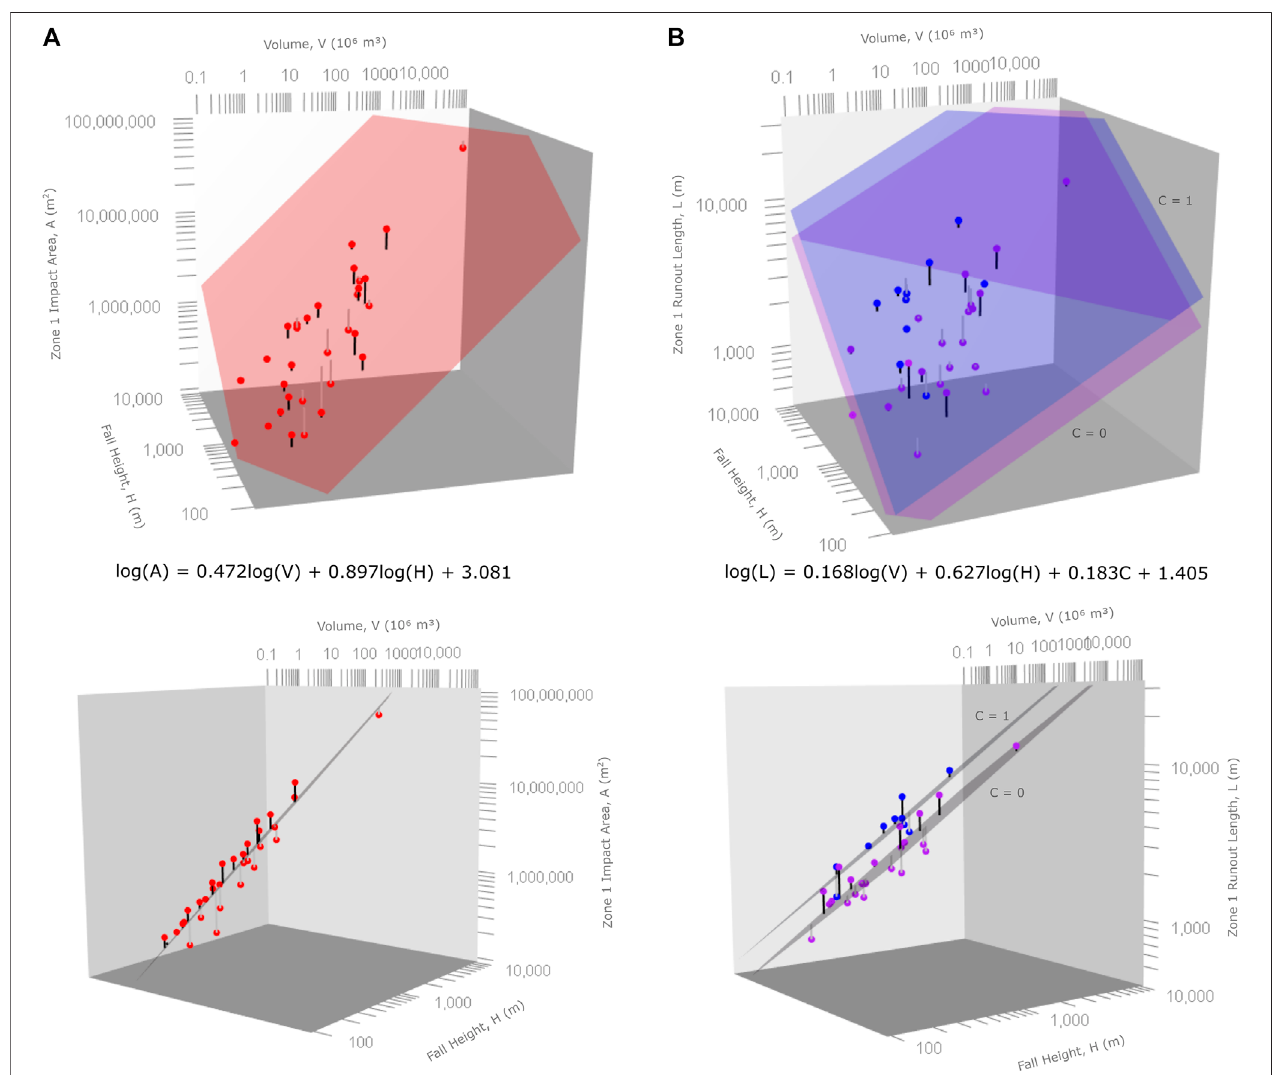
FIGURE 8 | Regression plots for (A) Zone 1 total impact area as a function of volume and fall height, plotted to show the variation in the measurements (top), and rotated to show the magnitude of the residuals (bottom), and ( B) Zone 1 runout length as a function of volume, fall height, and lateral con fi nement, where C (cid:2) 1 denotes laterallycon fi nedand C (cid:2) 0denoteslaterallyuncon fi nedpathtopography,plottedtoshowthevariationinthemeasurements(top),androtatedtoshowthemagnitudeof the residuals